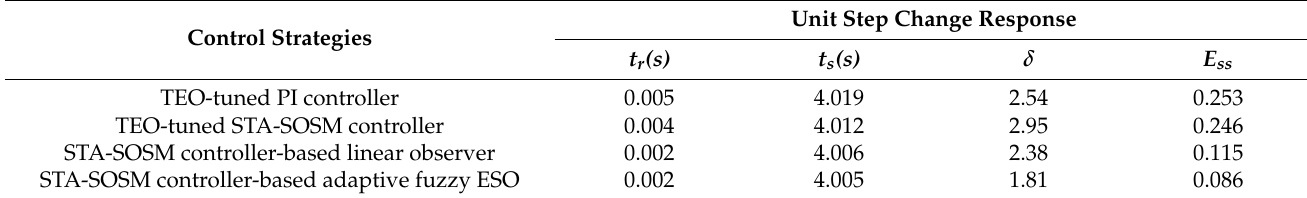
Table 3. Time-domain performances’ comparison for the controlled DC-link voltage